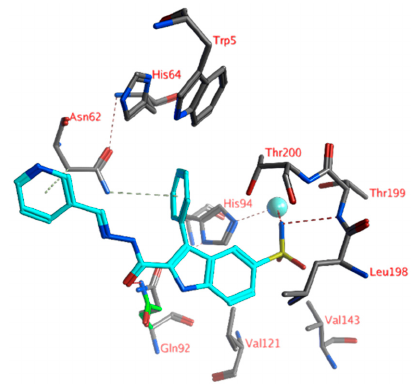
Figure 3. The docked pose of compound 7 (turquoise) in the active site of hCA XII (1jd0). Hydrogen bonds and interactions with the zinc ion are indicated in red dashed lines. H-arene interactions are indicated in yellow dashed lines. The zinc ion is indicated as a turquoise sphere. The Gln92 rotamer that was able to form a hydrogen bond with the ligand is indicated in green sticks.